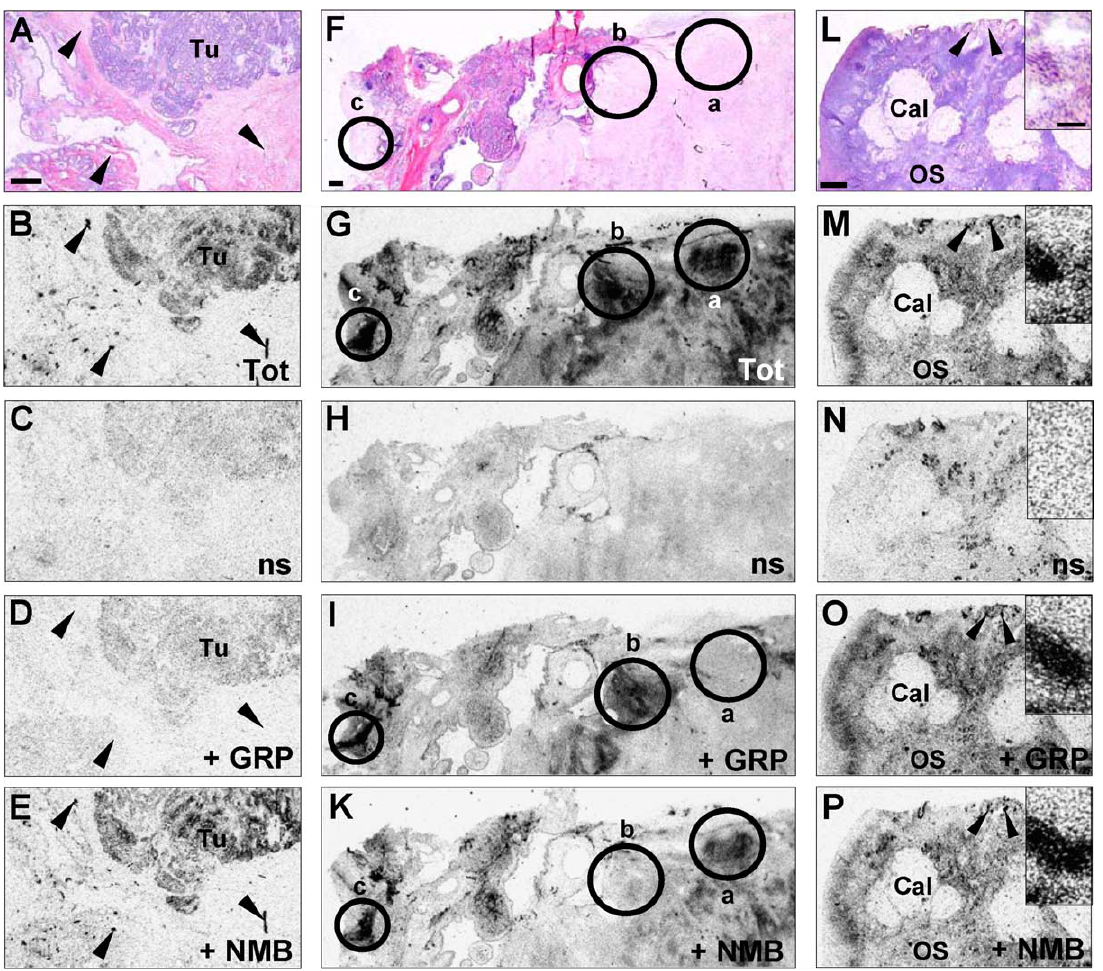
Fig. 5. Autoradiographic evidence for different bombesin-receptor subtypes in an endometrioid adenocarcinoma (left; A–E), a mature teratoma (middle; F–K) and a normal ovary (right; L–P) using the universal radioligand 125 I-[D-Tyr 6 , ß-Ala 11 , Phe 13 , Nle 14 ]-bombesin(6-14) with se- lective competitors. A, F, L: H&E-stained sections; bars = 1 mm. A: endometrioid adenocarcinoma with neoplastic cells (Tu) and abundant stroma with blood vessels (arrowheads). F: mature teratoma with an abundant histologically homogeneous neuroectodermal component (three foci circled) and a minor component of ectodermal tissue (middle-left). L: normal ovary with blood vessels (arrowheads) and corpora albicantia (cal) in ovarian stroma (os); bar = 1 mm. Insert showing a higher magnification of a blood vessel; bar = 0.1 mm. B, G, M: autoradiograms showing total binding of 125 I-[D-Tyr 6 , ß-Ala 11 , Phe 13 , Nle 14 ]-bombesin(6-14). B: the neoplastic cells (Tu) and numerous vessels (arrowheads) of the adenocarcinoma are labeled. G: focal labeling of the neuroectodermal (three foci circled) and ectodermal component. M: only the ovarian stroma (os) and some vessels (arrowheads; insert) are labeled. C, H, N: control sections showing non-specific binding. D, I, O: autoradiograms showing 125 I-[D-Tyr 6 , ß-Ala 11 , Phe 13 , Nle 14 ]-bombesin(6-14) binding in presence of 50 nM GRP. D: the radioligand is displaced in the neo- plastic cells (Tu) and vessels (arrowheads) of the adenocarcinoma. I: the radioligand is displaced in some areas (e.g. circle a), but not in others (e.g. circles b and c). O: no displacement of the radioligand is observed in the ovarian stroma (os) and the vessels (arrowheads; insert). E, K, P: autoradiograms showing 125 I-[D-Tyr 6 , ß-Ala 11 , Phe 13 , Nle 14 ]-bombesin(6-14) binding in presence of 50 nM NMB. E: virtually no displacement is observed in the neoplastic cells (Tu) and the vessels (arrowheads). Considering the displacement by GRP in D this pharmacological profile is characteristic for GRP-receptors. K: foci of complete displacement of the radioligand (e.g. circle b) by NMB without displacement by GRP in I indicate expression of NMB-receptors. In addition, areas without displacement by NMB (e.g. circles a and c). Some of them with (e.g. circle a) others without (e.g. circle c) displacement by GRP in I, indicating expression of GRP-receptors and bb3, respectively. P: likewise in O, no displacement of the radioligand is observed in the ovarian stroma (os) and the vessels (arrowheads; insert). This pharmacological profile is characteristic for the bombesin-receptor subtype bb3. No other bombesin-receptor subtype is